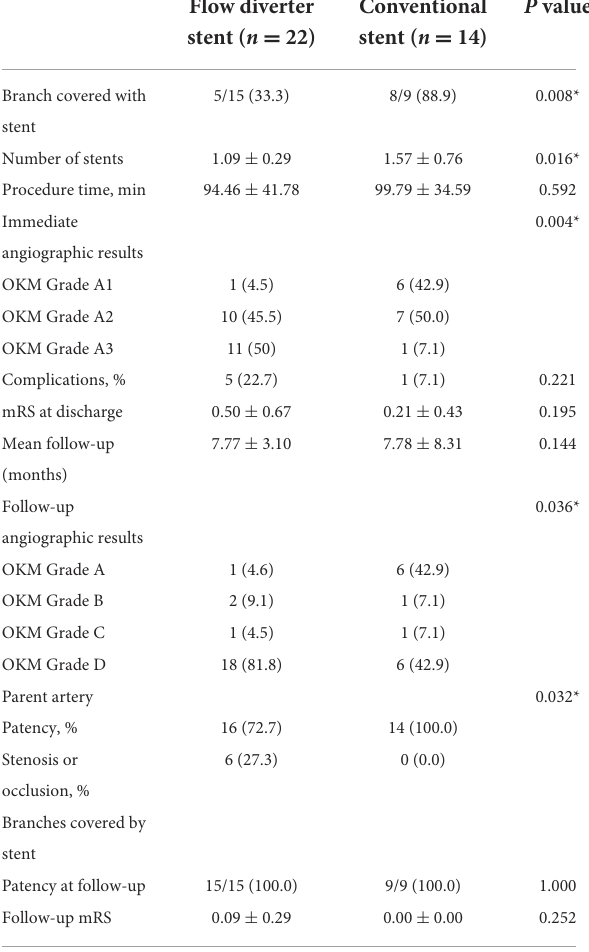
TABLE 2 Treatment details, complications, and angiographic and clinical